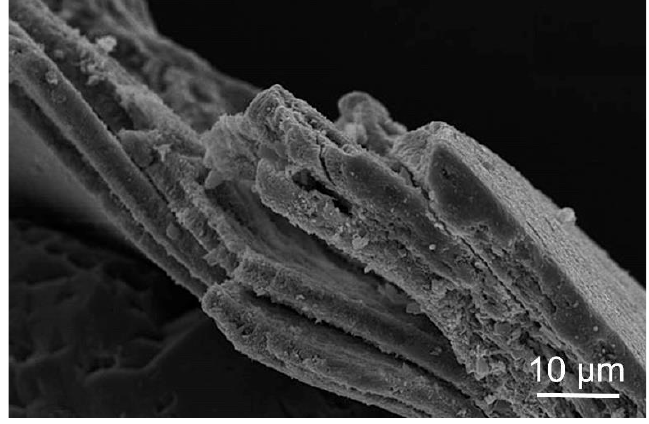
Figure 11. Microlamellar fabric in Torellella sulcata from the upper Cambrian of Estonia.